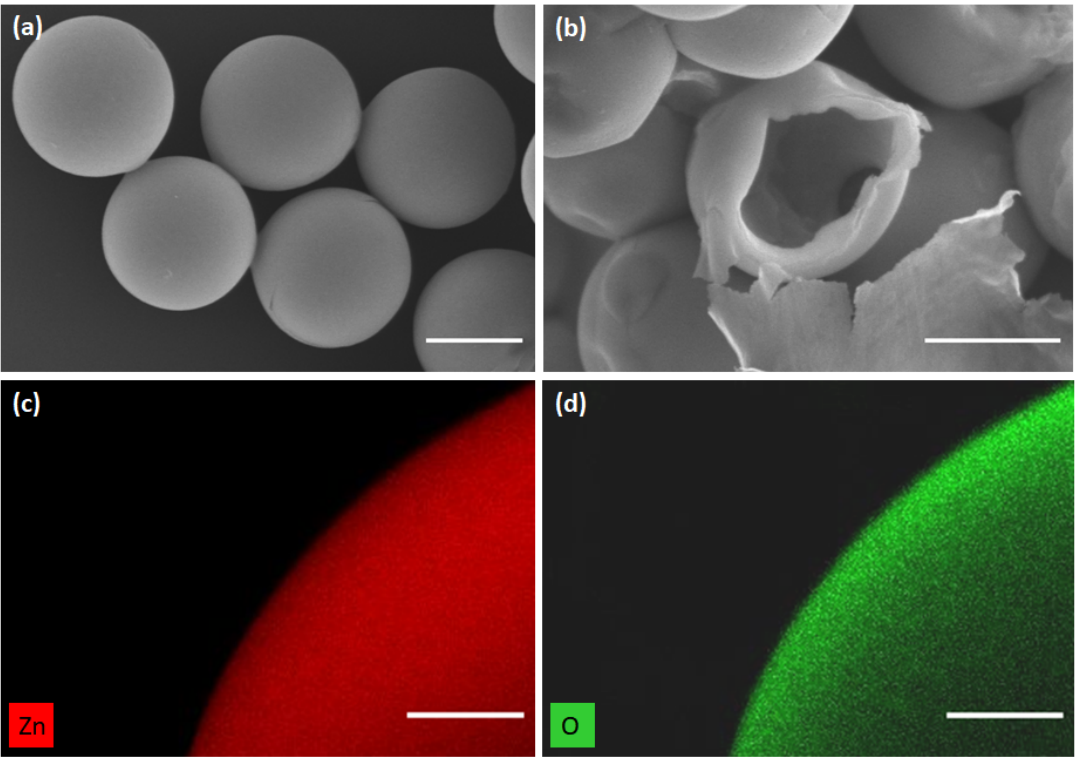
Figure 3. ( a ) SEM images of 16.5 µ m size zinc oxide microcapsules; ( b ) shell thickness was found about 0.6 µ m; and ( c , d ) element mapping images of the ZnO microspheres. Scale bars: ( a , b ) 10 µ m; and ( c , d ) 2 µ m.